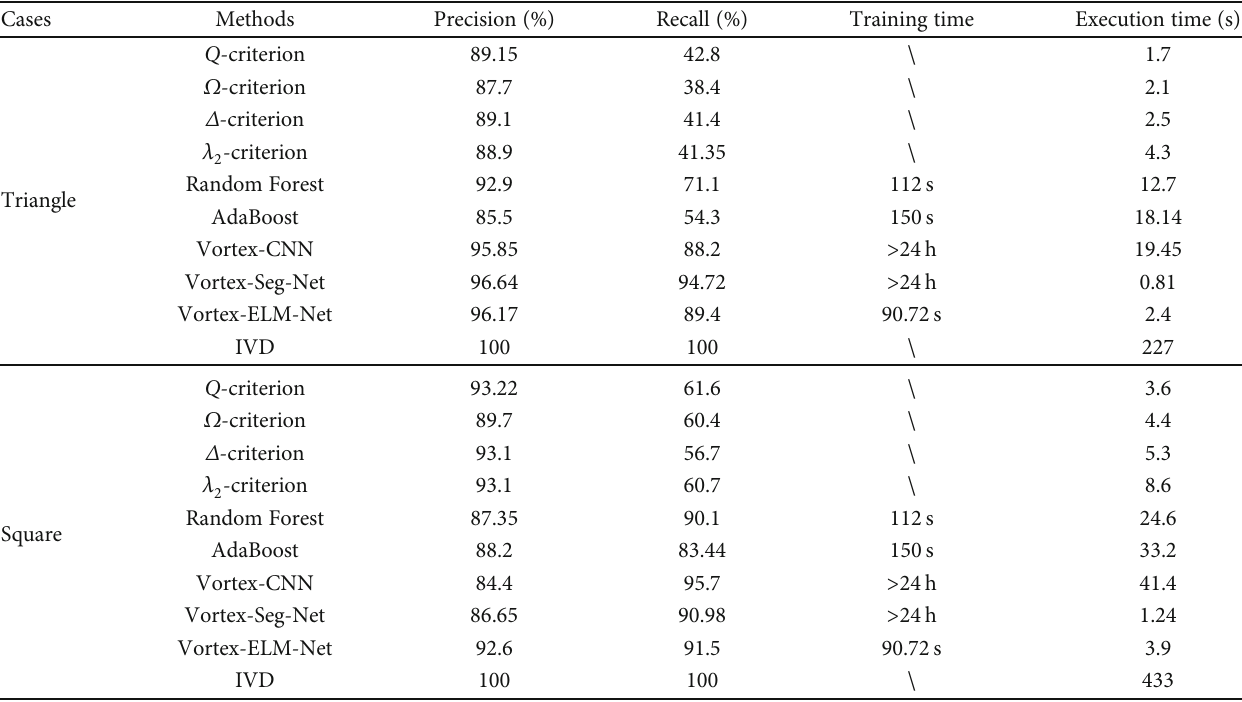
Table 2: The performance of di ff erent methods in the triangle fl ow fi eld of 101 × 381 and the square fl ow fi eld of 101 × 761 .